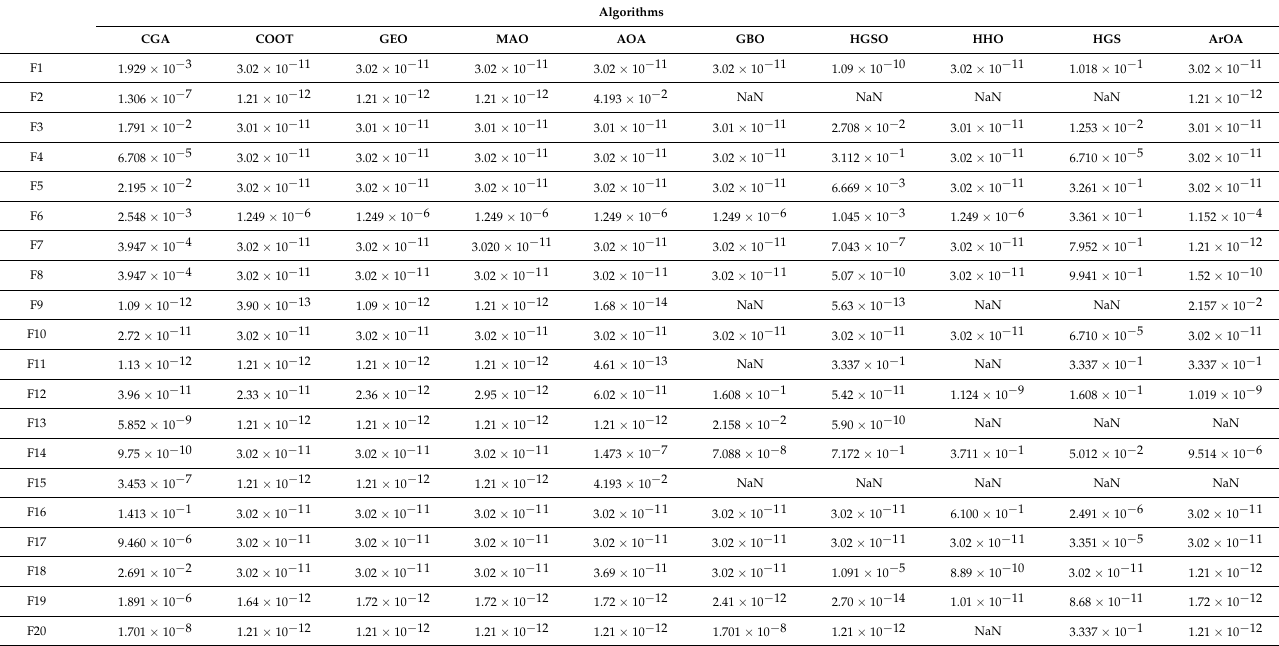
Table 3. The p -values of the Wilcoxon rank-sum test with 5% significance for JSOA vs. other algorithms (20 benchmark functions with 30 dimensions). NaN means “Not a Number” returned by the test.